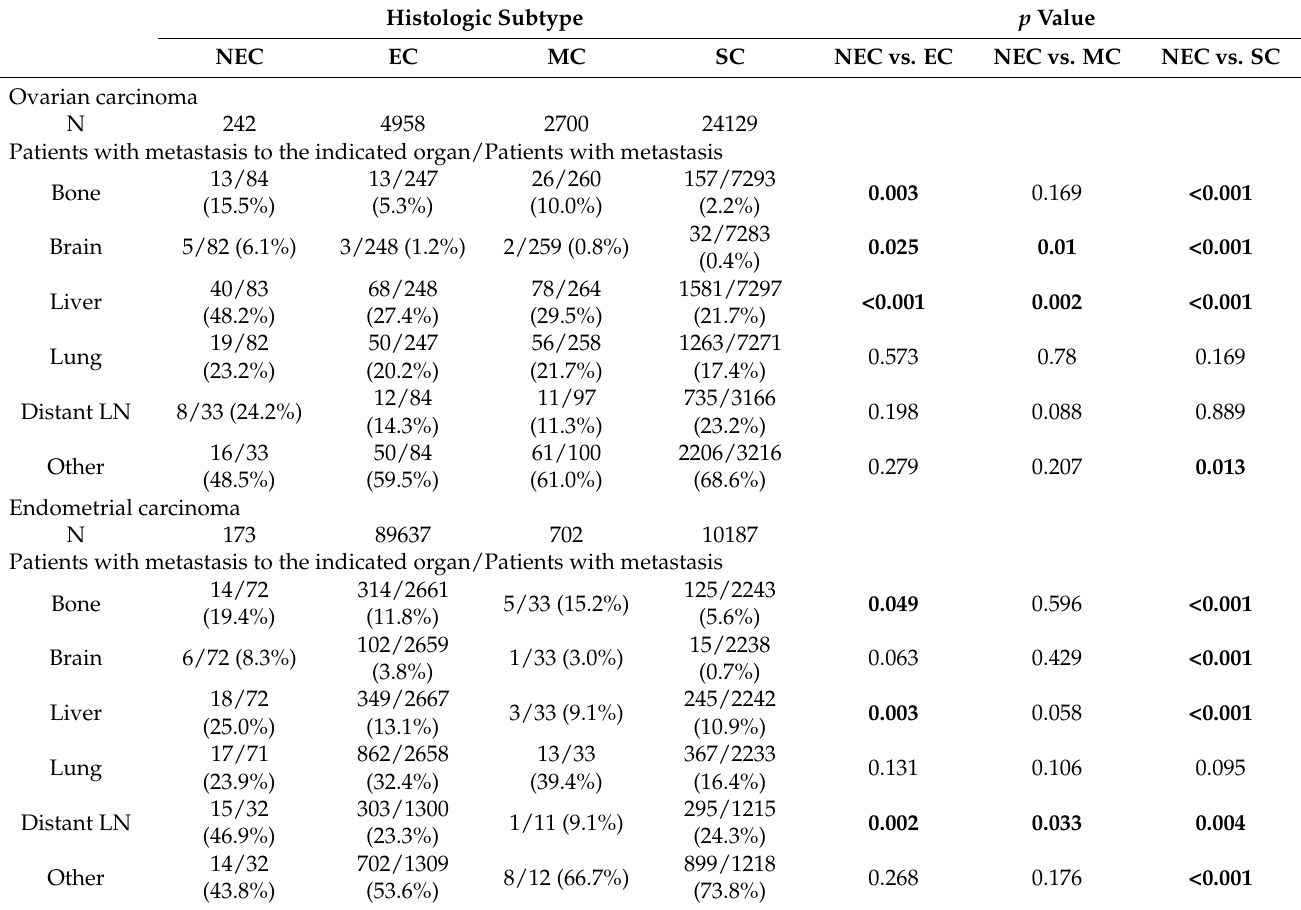
Table 2. Comparison of the rate of organotrophic metastasis among different histologic subtypes of ovarian carcinomas and endometrial carcinomas retrieved from the Surveillance, Epidemiology, and End Results (SEER) database. Each percentage indicates the percentage of patients with metastasis to the indicated organ divided by the total number of patients with